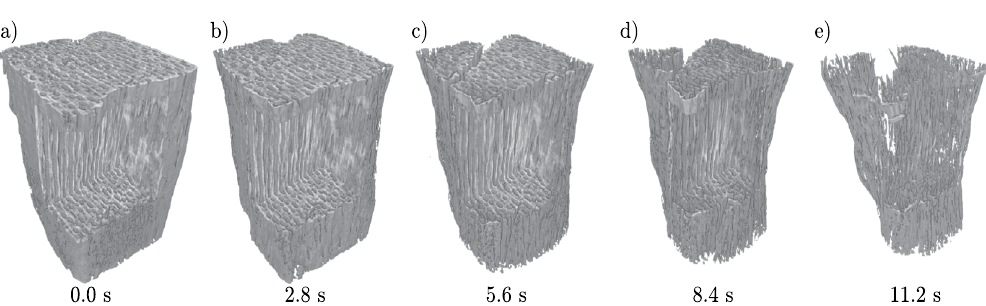
Figure 5. Rendered 3d structure of the burning match at different times. For the corresponding movie see Supplemental